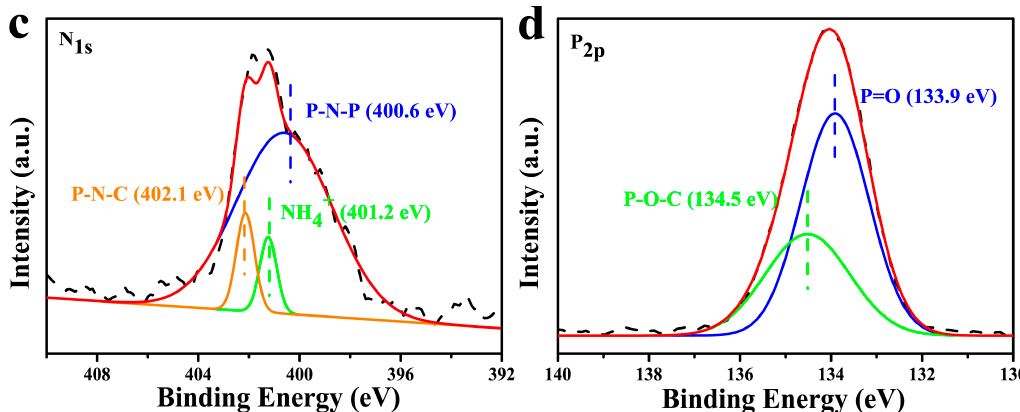
Figure 10. XPS survey spectra of PP1 and PP6 ( a ); high-resolution XPS spectras of PP6 ( b – d ).